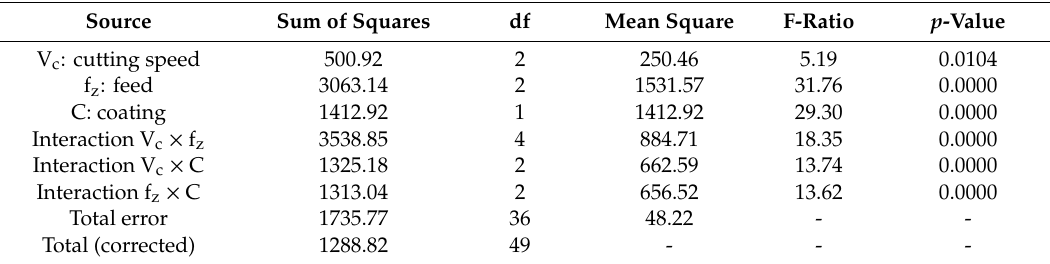
Table 2. Two-factor ANOVA for height deviation.